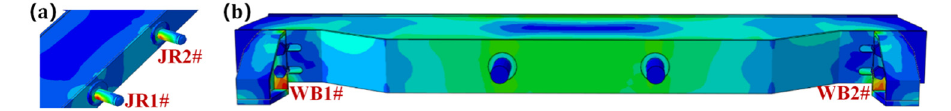
Figure 9: Critical locations in longitudinal and horizontal loading: ( a ) JR1# and JR2# in horizontal loading and ( b ) WB1# and WB2# in longitudinal